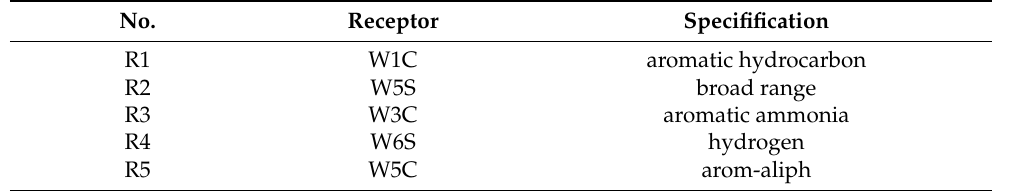
Table 1. The description of receptor on